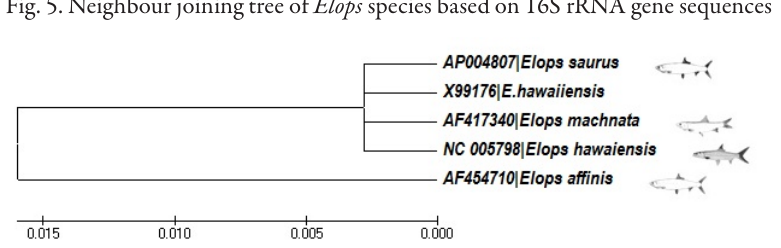
Fig. 5. Neighbour joining tree of Elops species based on 16S rRNA gene sequences